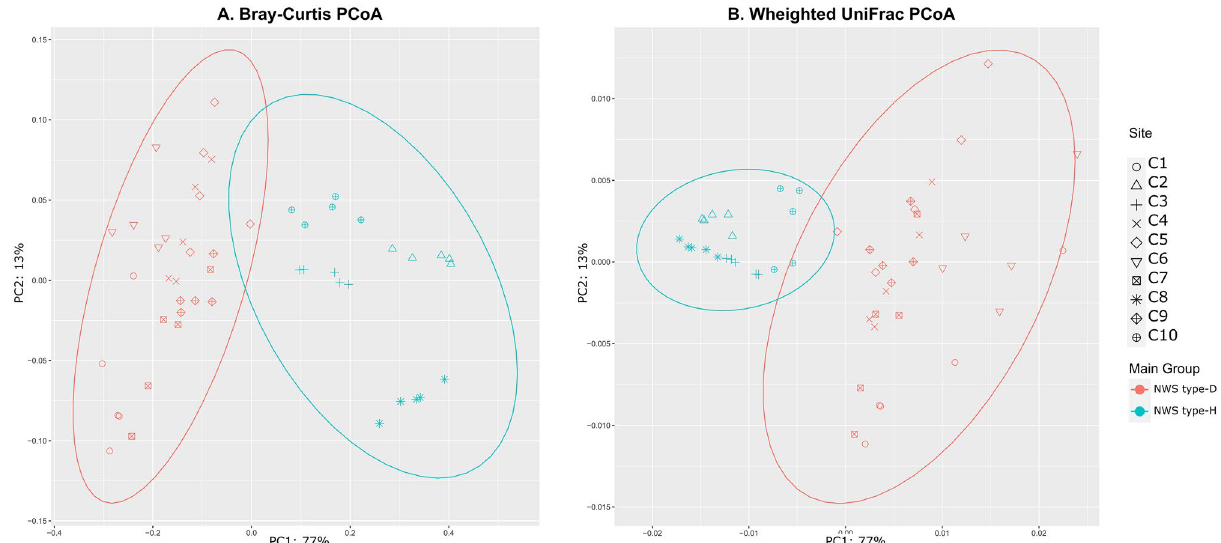
Figure 4. Beta diversity plots of NWS samples based on Principal coordinates analysis (PCoA) of ( A ) Bray– Curtis and ( B ) weighted Unifrac distance. Points represent samples, while color indicates dairy farms. The percentage reported on axes represent the amount of total variance depicted by each of them. ( A , B ) were plotted with R v.4.1.1, while the ellipses were calculated and drawn with 0.95 of confidence level using ggplot v.2 3.3.5